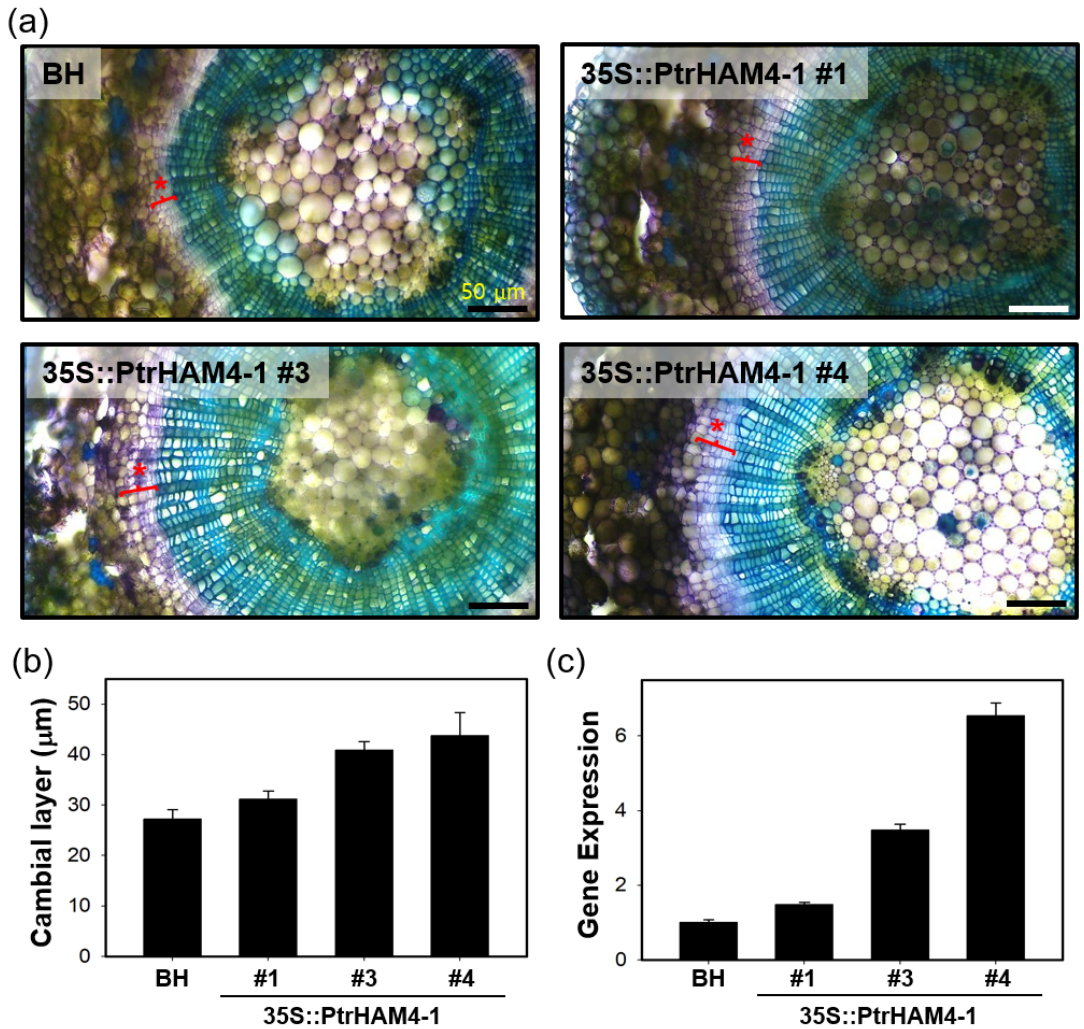
Figure 8. Transgenic poplar overexpressing PtrHAM4-1 resulted in an increased cambium development. ( a ) Observation of cambium development in stem cross sections of 3-month-old transgenic poplars and wild type BH clone (BH) grown in test tube. Red braces under the red star indicate the cambial layers. Scale bars represent 50 µ m. ( b ) Quantification of cambial layers of transgenic poplars compared to BH. The length of cambial layers was measured in stem sections from five ramets of each transgenic lines described in (a). Error bars indicate S.E. ( n = 5). ( c ) Expression of the PtrHAM4-1 gene in the independent transgenic poplar lines compared to BH. First-strand cDNA was synthesized from the total RNA extracted from stem tissues and used as a template in the qRT-PCR experiments.